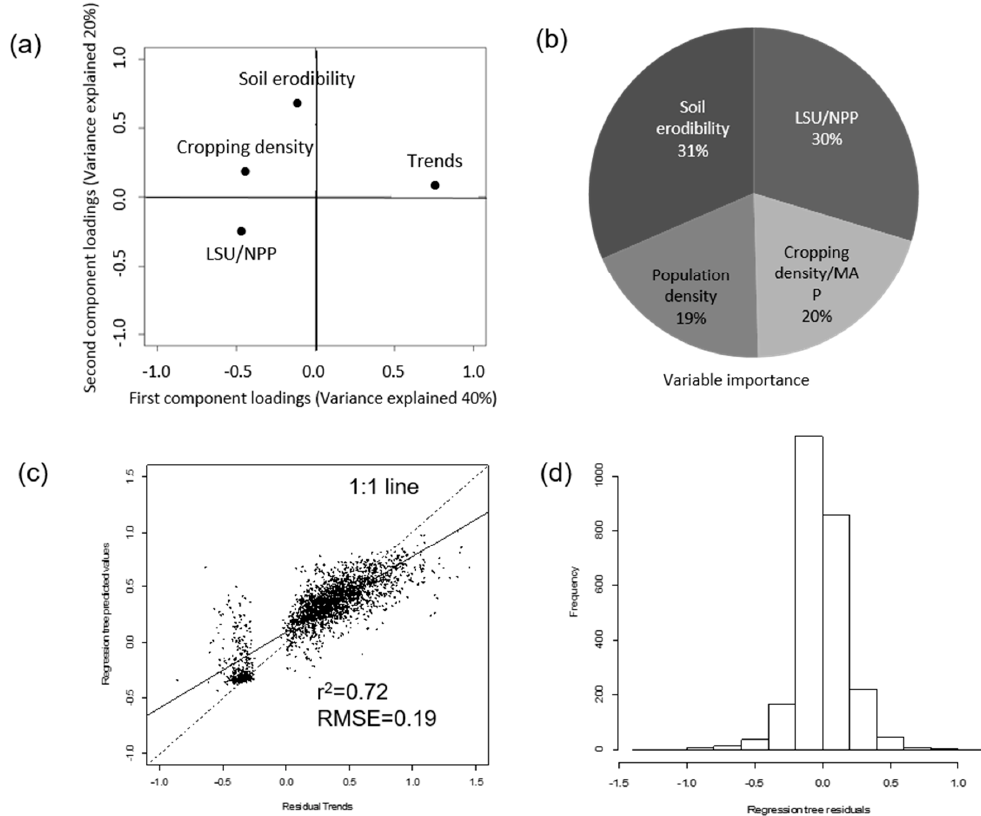
Figure 6. The relationship between significant RESTREND values and four explanatory variables, soil erodibility factor, livestock unit density normalized by site productivity (LSU/NPP), fraction land used for agriculture (cropping density), and population density. ( a ) biplot of the first and second principal component loadings of a principal component analysis; ( b ) variable importance values calculated by the Random Forest (RF) regression tree model; ( c ) comparison between RESTREND values modeled from the NDVI gs time series (x-axis) and RESTREND values predicted by RF analysis (y-axis); and ( d ) histogram of the differences between the plotted values in ( c ). Residual trends insignificantly different from zero were excluded. Table 4. Spatial variation in RESTREND values correlated with land use (livestock unit density—LSU and cropping density—CD), land use and soil properties, and land use and land cover, using RF regression tree models. LSU/NPP—livestock unit density normalized by site primary productivity; CD/MAP—cropping density normalized by mean annual precipitation.